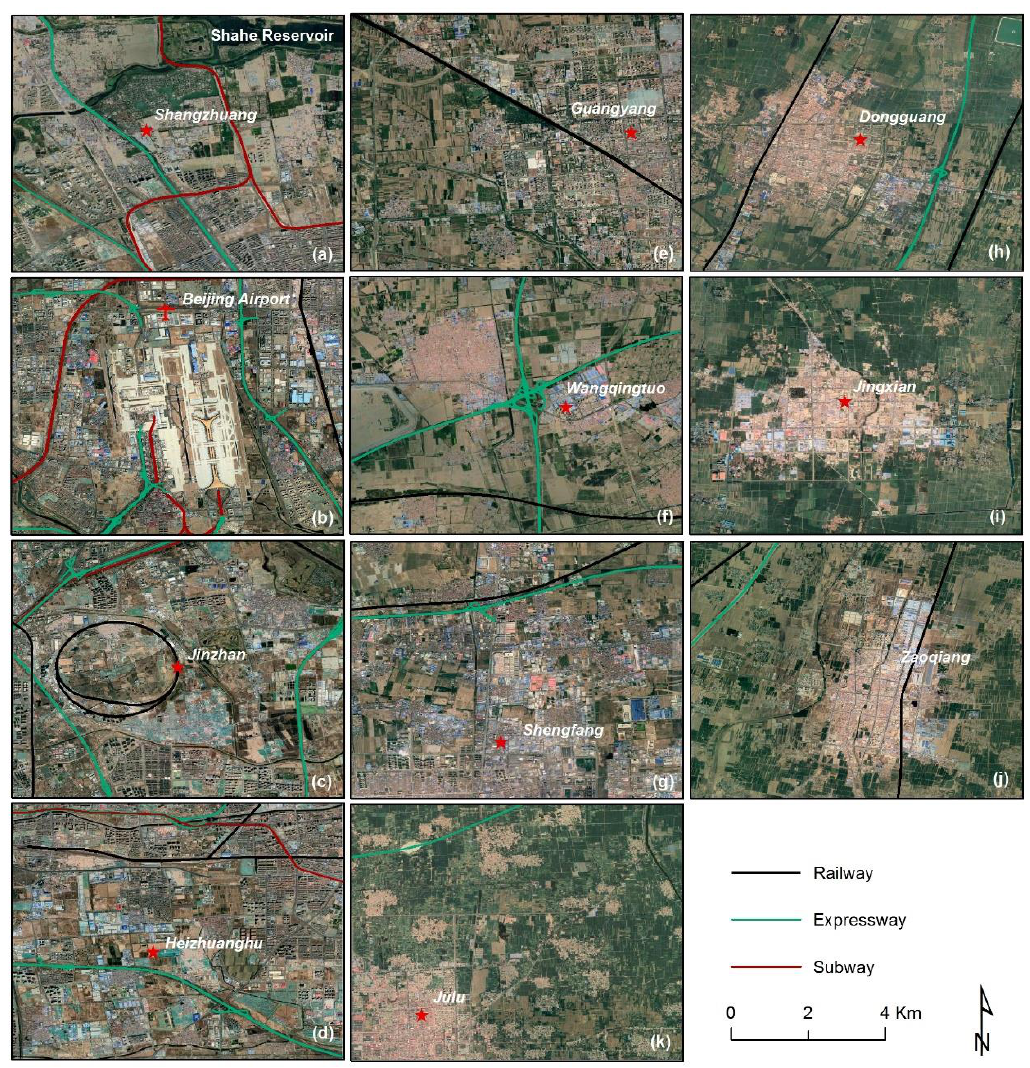
Figure 12. Remote sensing images in eleven subsidence features areas. ( a – k ) is the land use in Shangzhuang, Beijing Airport, Jinzhan, Heizhuanghu, Guangyang, Wangqingtuo, Shengfang, Dongguang, Jingxian, Zaoqiang and